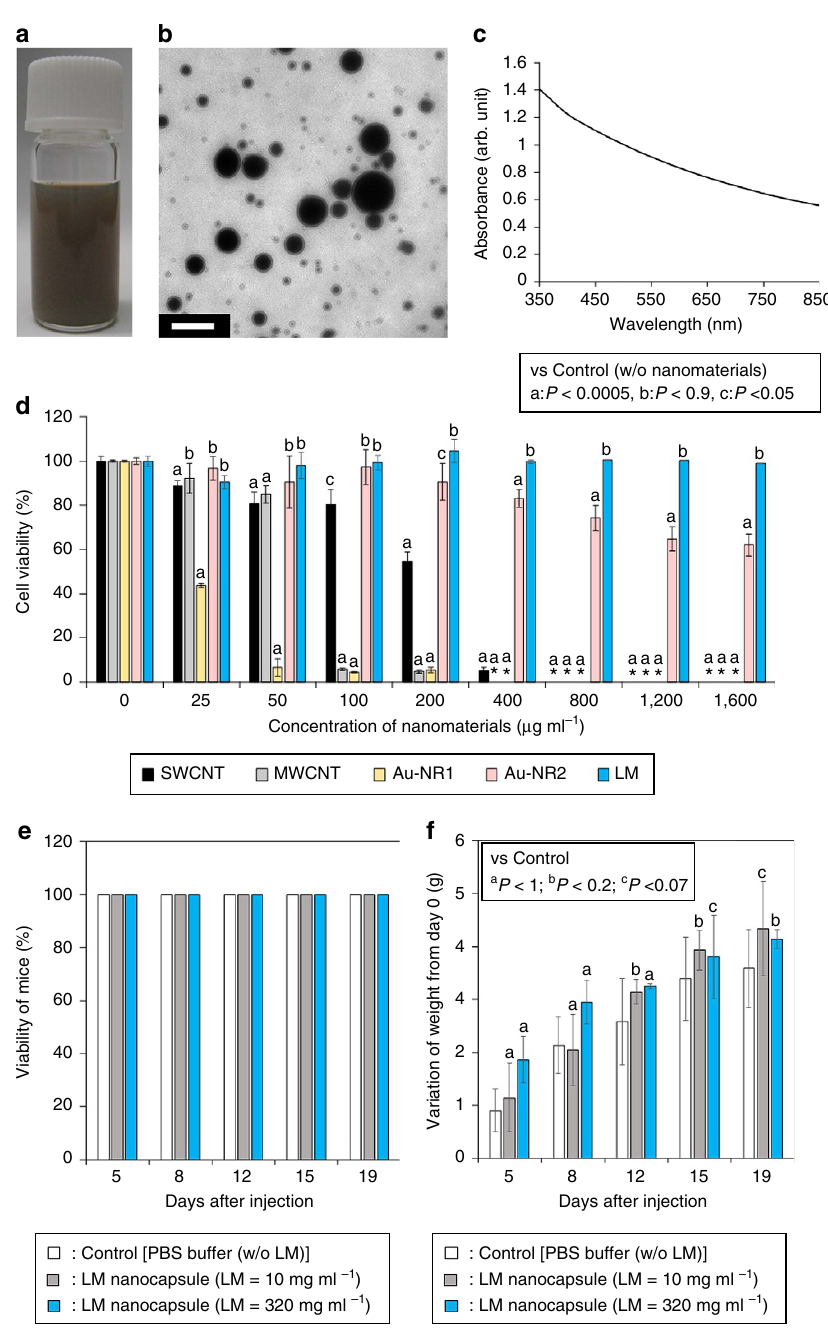
Figure 2 | Characterization of LM nanocapsules. ( a ) Vial containing an aqueous suspension of LM nanocapsules (LM concentration: 115 m gml (cid:2) 1 ). ( b ) TEM image of LM nanocapsules. Scale bar, 200nm. ( c ) Ultraviolet–visible–NIR absorbance spectrum of LM nanocapsules (LM concentration: 500 m gml (cid:2) 1 ). ( d ) Cell viability following treatment with various nanomaterials. SWCNT, single-walled carbon nanotube; MWCNT, multi-walled carbon nanotube; Au-NR1, methyl-terminated-hydrophilic polymer-conjugated gold nanorod; Au-NR2, methoxy-PEG 2000 -SH modified gold nanorod. Error bars represent s.d.’s of five separate measurements. *N.D.: not determined because all of cells were dead. The standardized percentage of mitochondrial enzyme activity compared with control. Statistical analyses were performed using ANOVA (Tukey’s test). a P o 0.0005; b P o 0.9; c P o 0.05. ( e ) Viability and ( f ) body weight of the mice ( N ¼ 5) following the injection of LM nanocapsules observed for 19 days. Data represent the mean of five determinations; error bars show the s.d. a P o 1; b P o 0.2; c P o